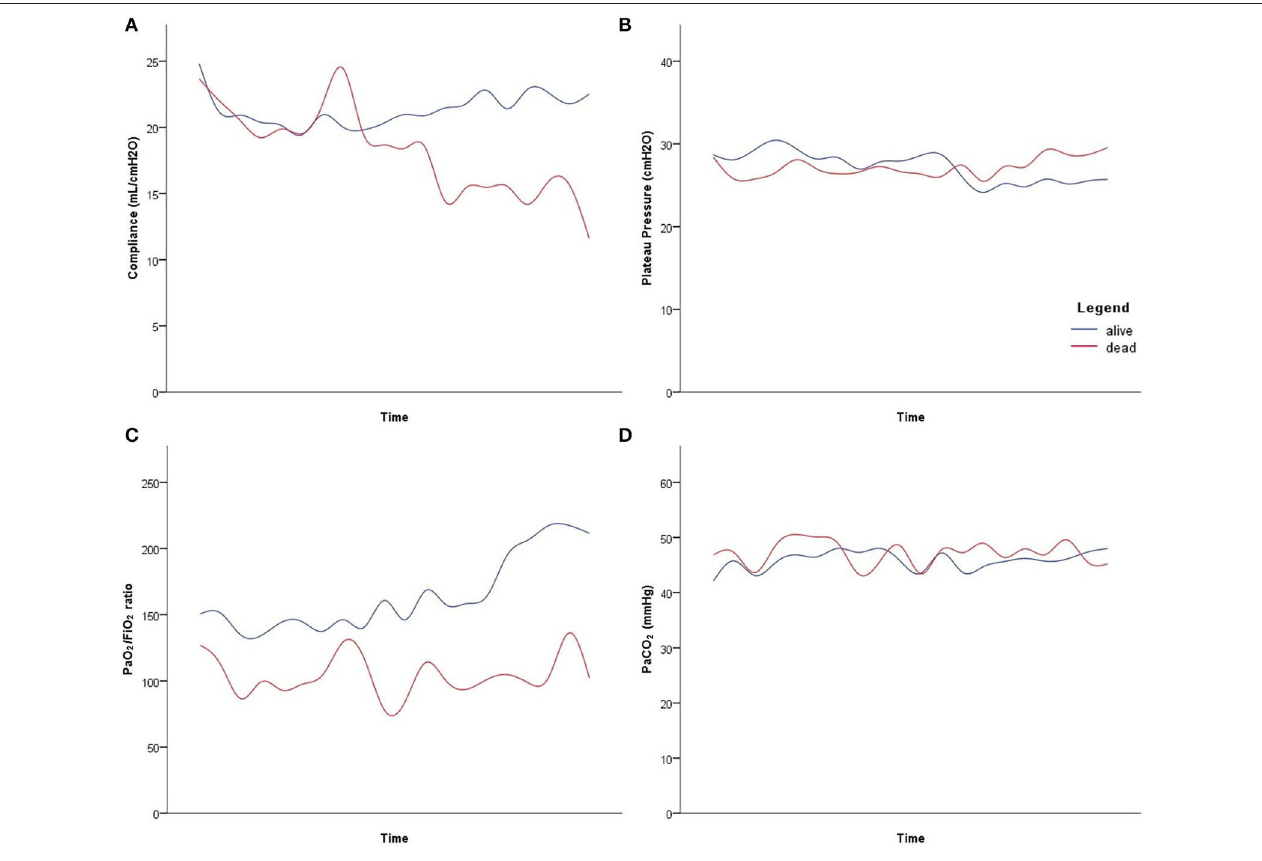
FIGURE 2 | Evolution of the mechanical respiratory parameters under venovenous extracorporeal membrane oxygenation in deceased patients (red line) and in patients who were discharged alive from intensive care unit (blue line). Time was standardized for every patient, to have comparable x-axis graphical representation, with the first and last point representing the first and last value under extracorporeal membrane oxygenation, respectively. (A) Compliance of the respiratory system. (B) Plateau pressure. (C) Arterial partial pressure of oxygen/inspired fraction of oxygen (PaO 2 /FiO 2 ) ratio. (D) arterial partial carbon dioxide pressure (PaCO 2